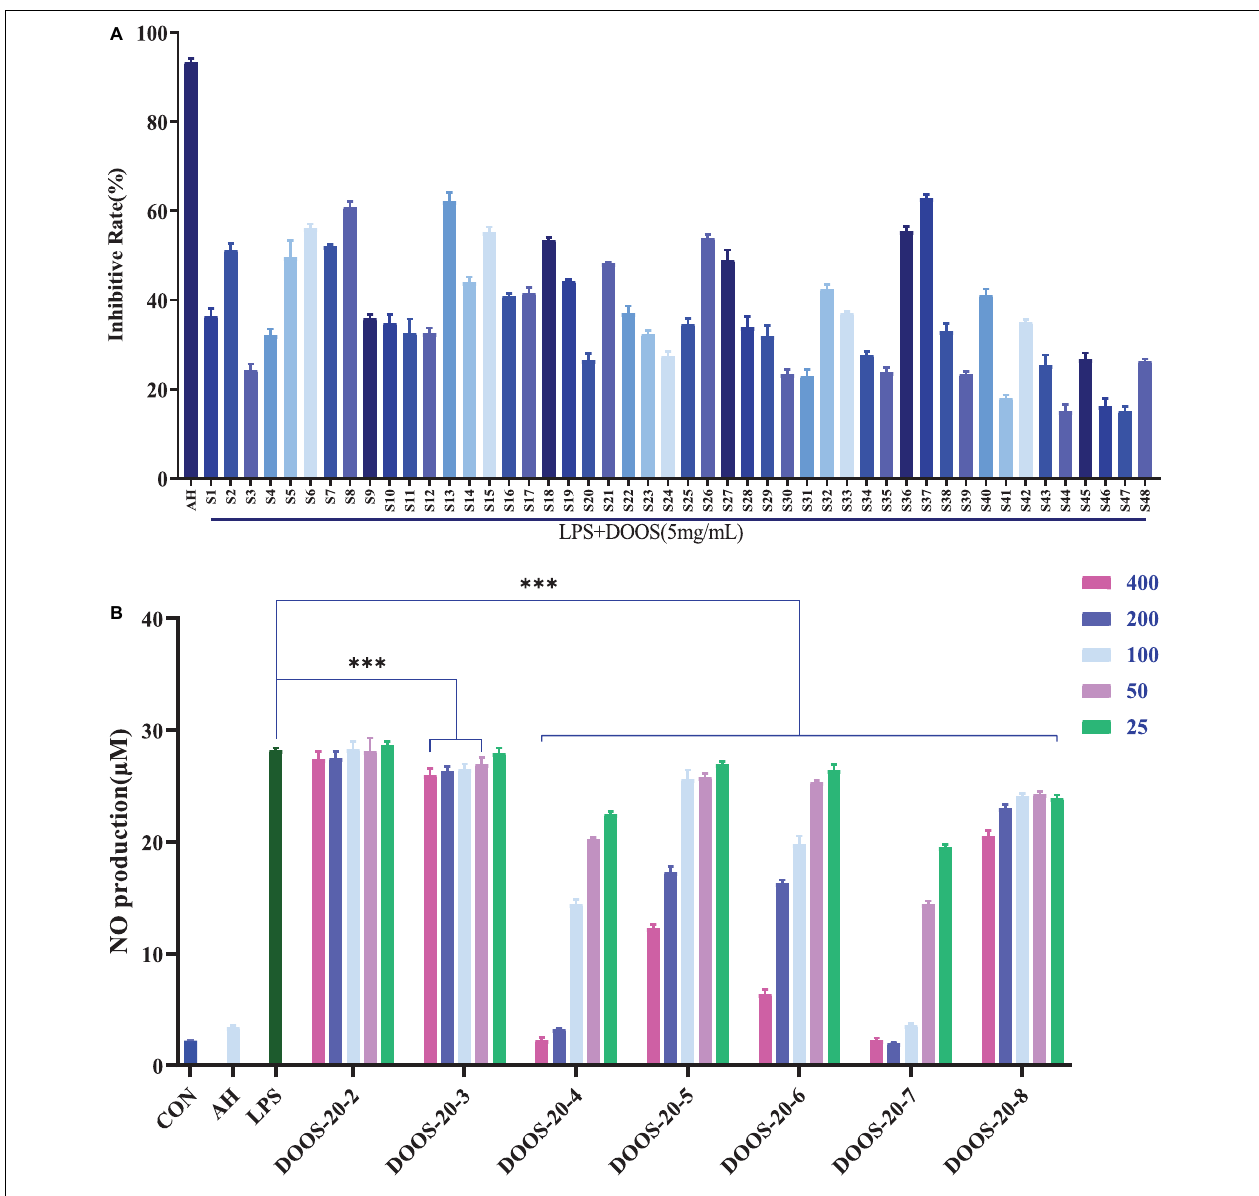
FIGURE 5 | (A) Nitric oxide (NO) inhibition rate of LPS induced RAW 264.7 cells with different batches of DOOS. The cells were treated with different batches of DOOS (5 mg/mL, the concentration of the drug is calculated by the mass of the corresponding raw herb) for 1 h prior to stimulation and LPS (1 µ g/mL) for 24 h. Values show the means and standard deviations of different concentrations performed in triplicate. (B) Effects of DOOS-20 at different concentration gradients (400, 200, 100, 50, 25 µ g/mL) in each purified section on production of NO in LPS induced RAW 264.7 cells. The cells were treated with different concentration sof DOOS-20 each purified section for 1 h prior to stimulation and LPS (1 µ g/mL) for 24 h. Values show the means and standard deviations of different concentrations performed in triplicate. ∗∗∗ p < 0.001 significantly different from the LPS group; ns, no